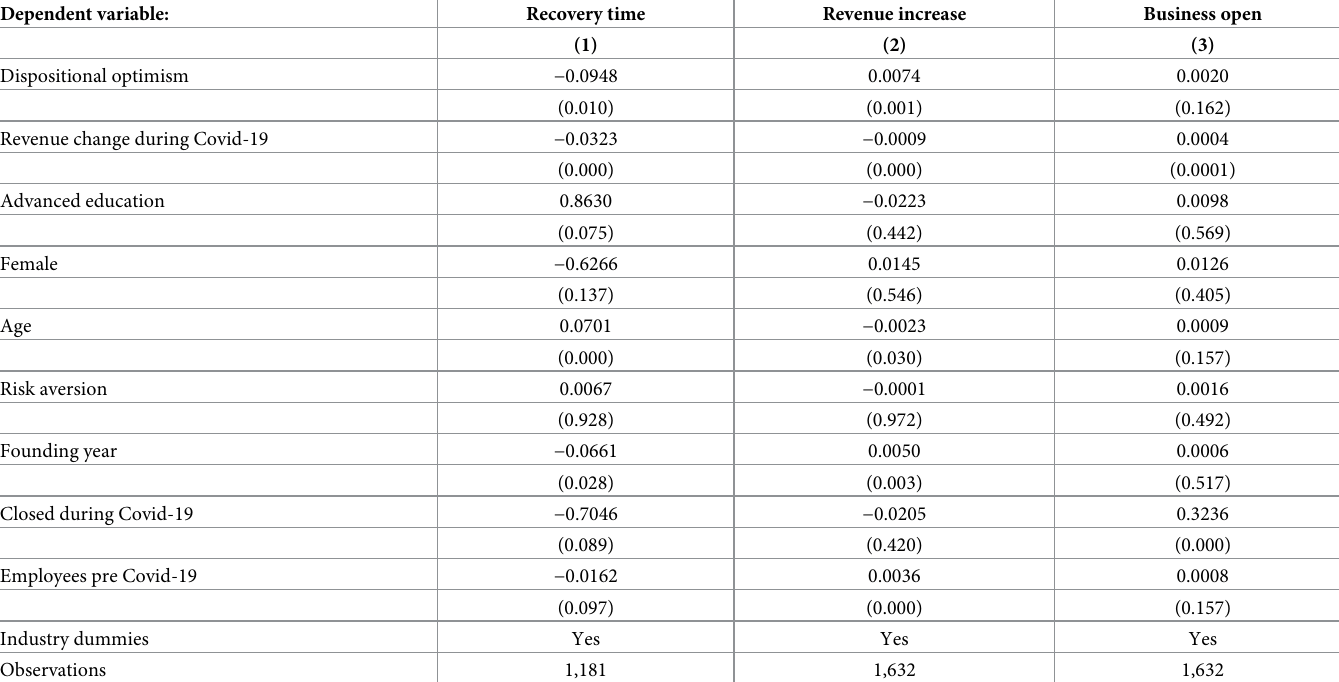
Table 4. Optimism and business